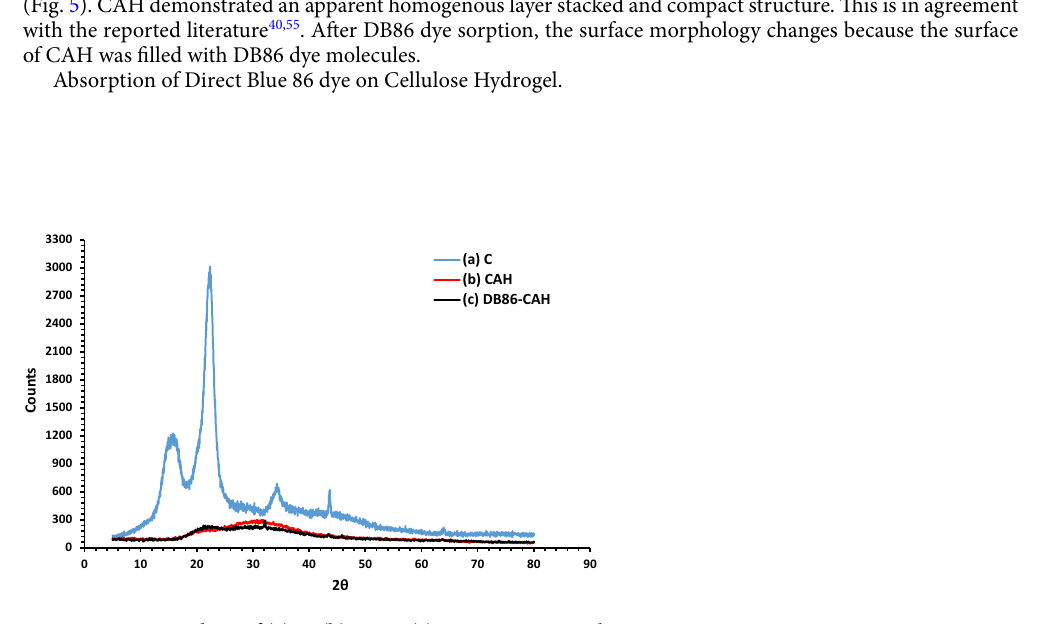
Figure 4. XRD analysis of (a) C, (b) CAH, (c) DB86-CAH samples.